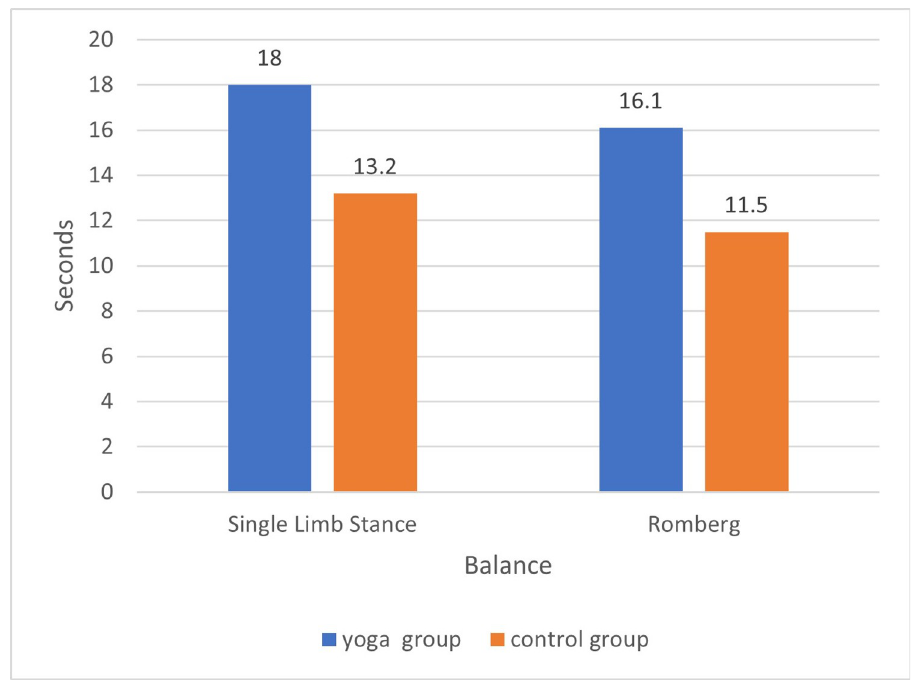
Fig 6. Posttest comparison of